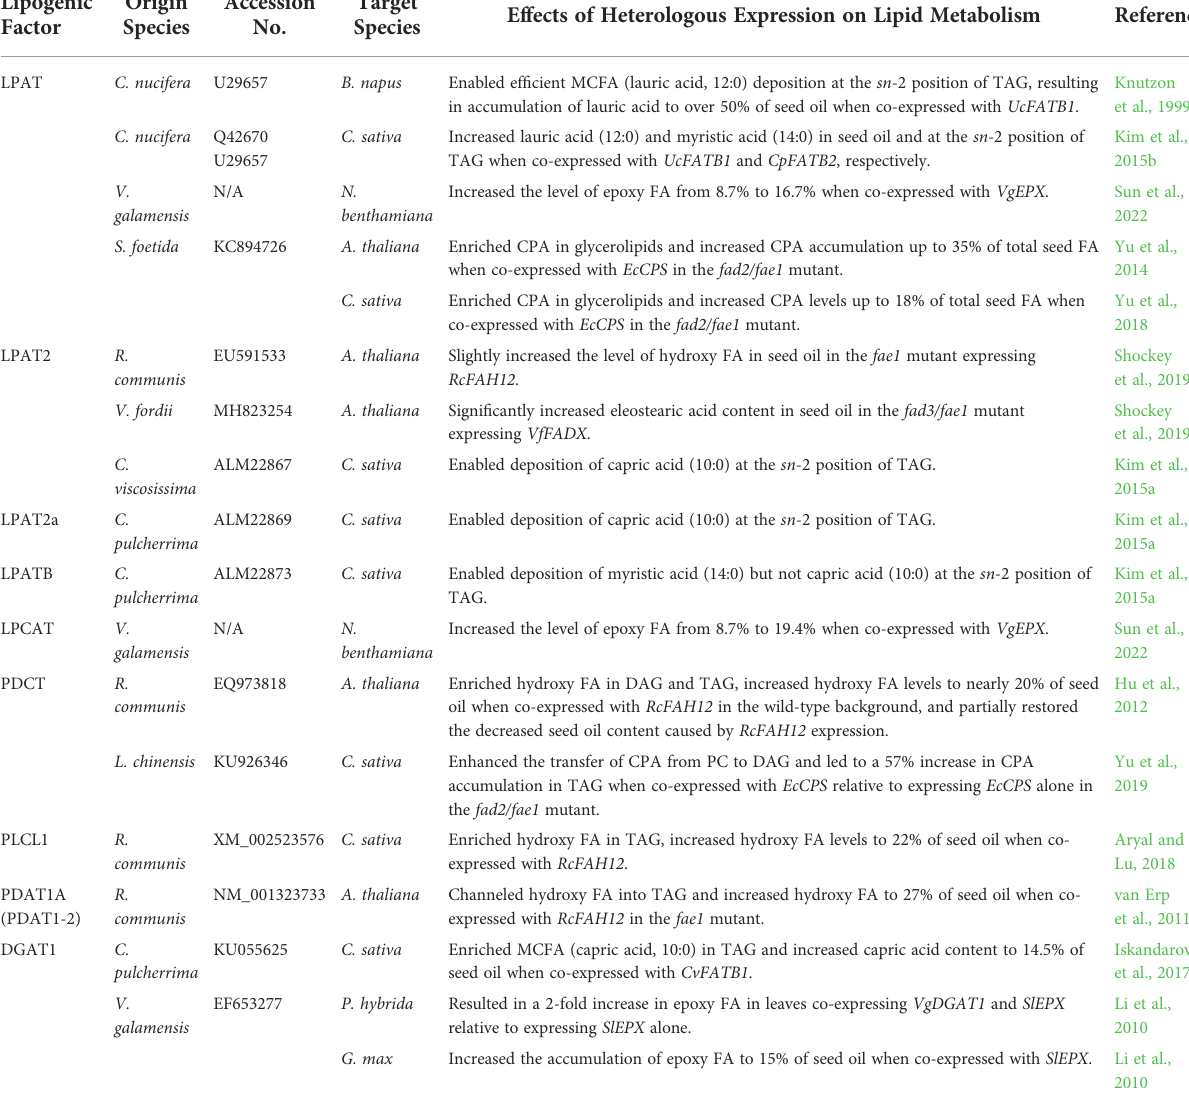
TABLE 2 List of specialized lipogenic factors involved in glycerolipid assembly used for lipid engineering in